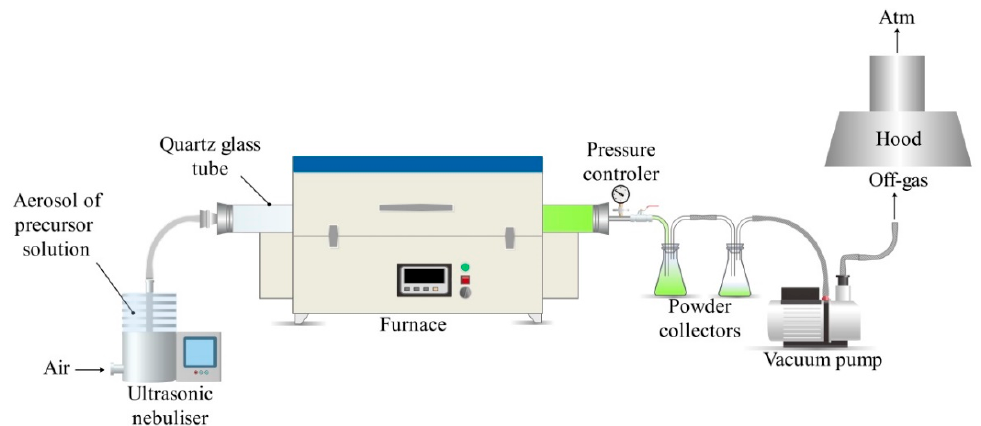
Figure 2. Schematic illustration of experimental setup for the ultrasonic spray pyrolysis (USP) synthesis of WO 3 .